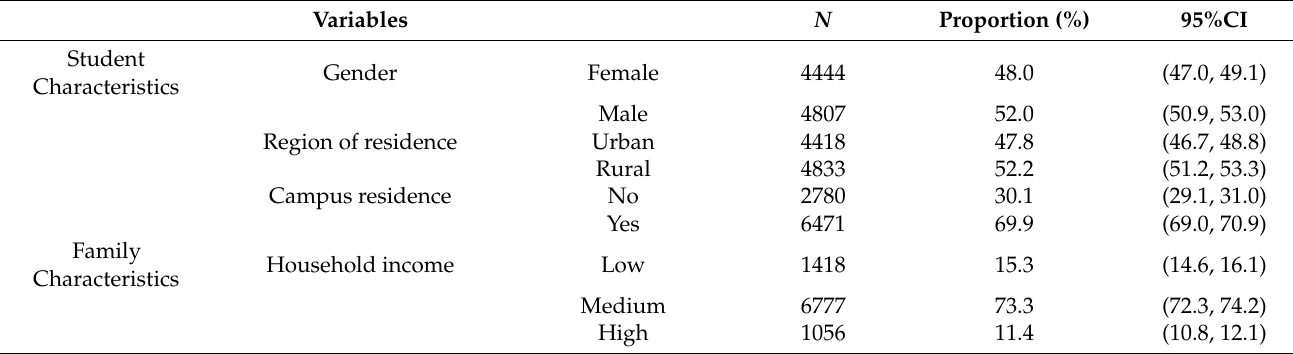
Table 1. Description of the general participant